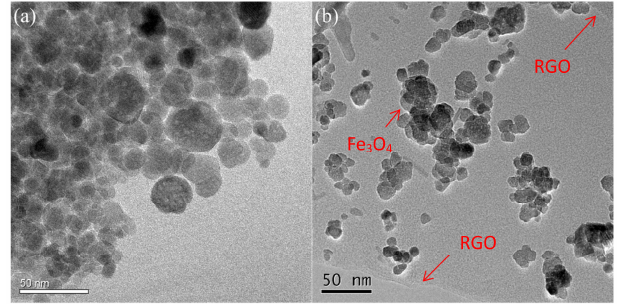
Figure 1. TEM of ( a ) Fe 3 O 4 nanoparticles, ( b ) RGO/Fe 3 O 4 nanocomposites.